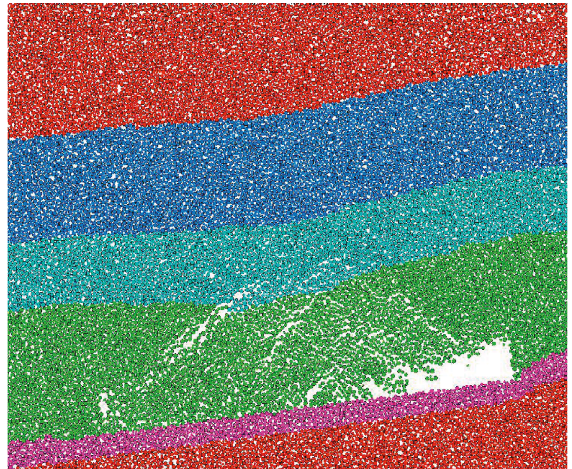
Figure 4: Effect of the coal seam’s dip angle (15 ° ) on coal caving.